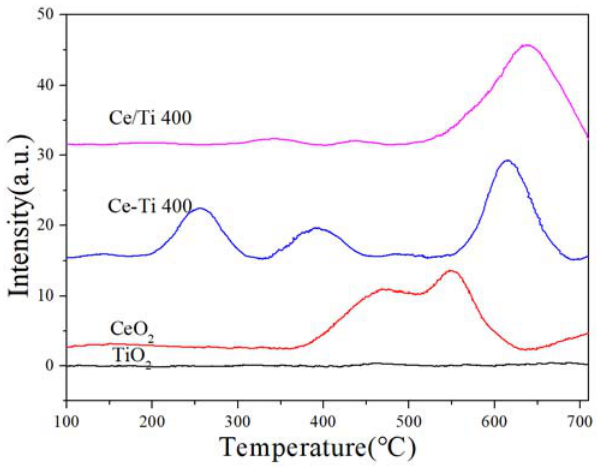
Figure 8. H 2 -TPR profiles of Ce-Ti-400 and Ce/Ti-400.